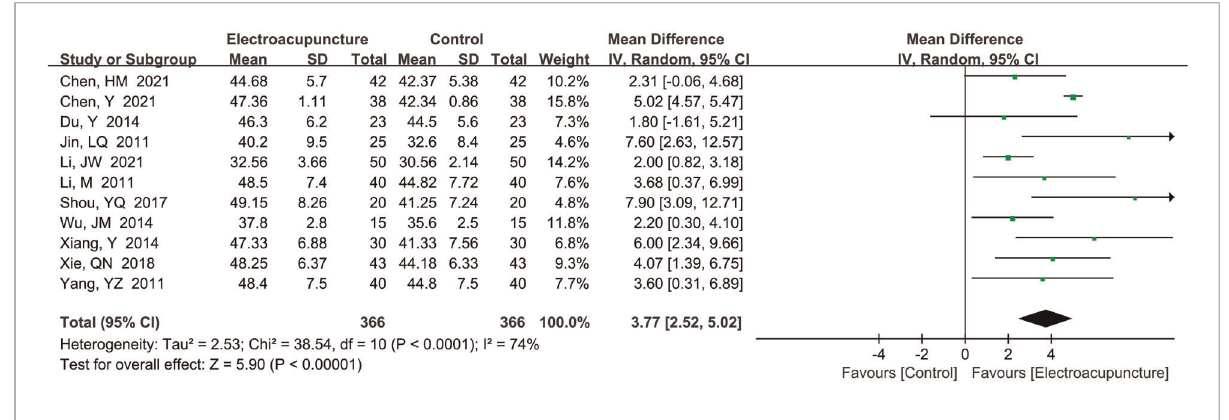
FIGURE 9 A forest plot showing the middle fi nger-carpal SCV.